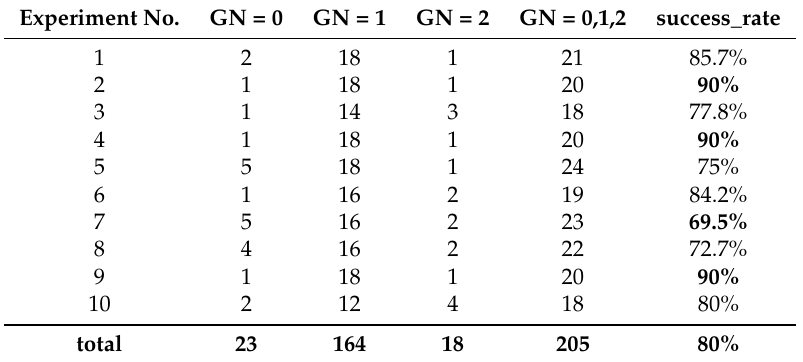
Table 4. Picking the white square towels in a laundry basket (GN: the number of towels grasped). Experiment